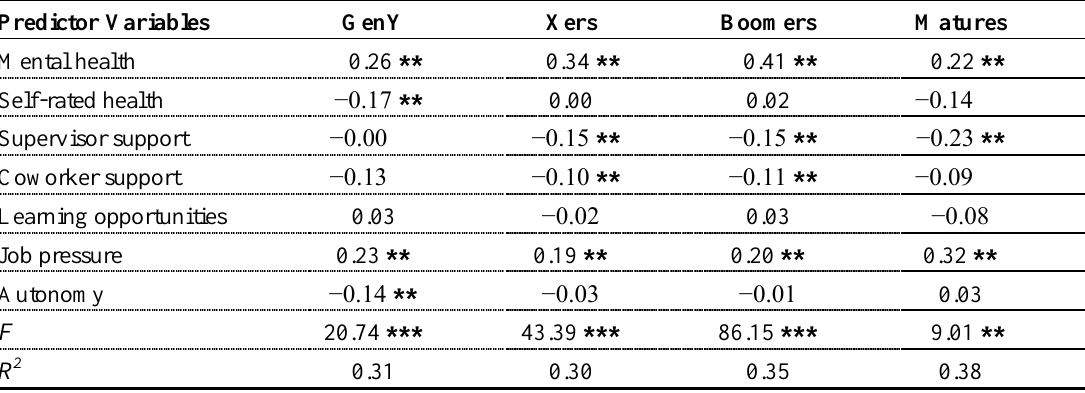
Table 3. Regressions for work interfering with family (WIF) on predictor variables by generational group.